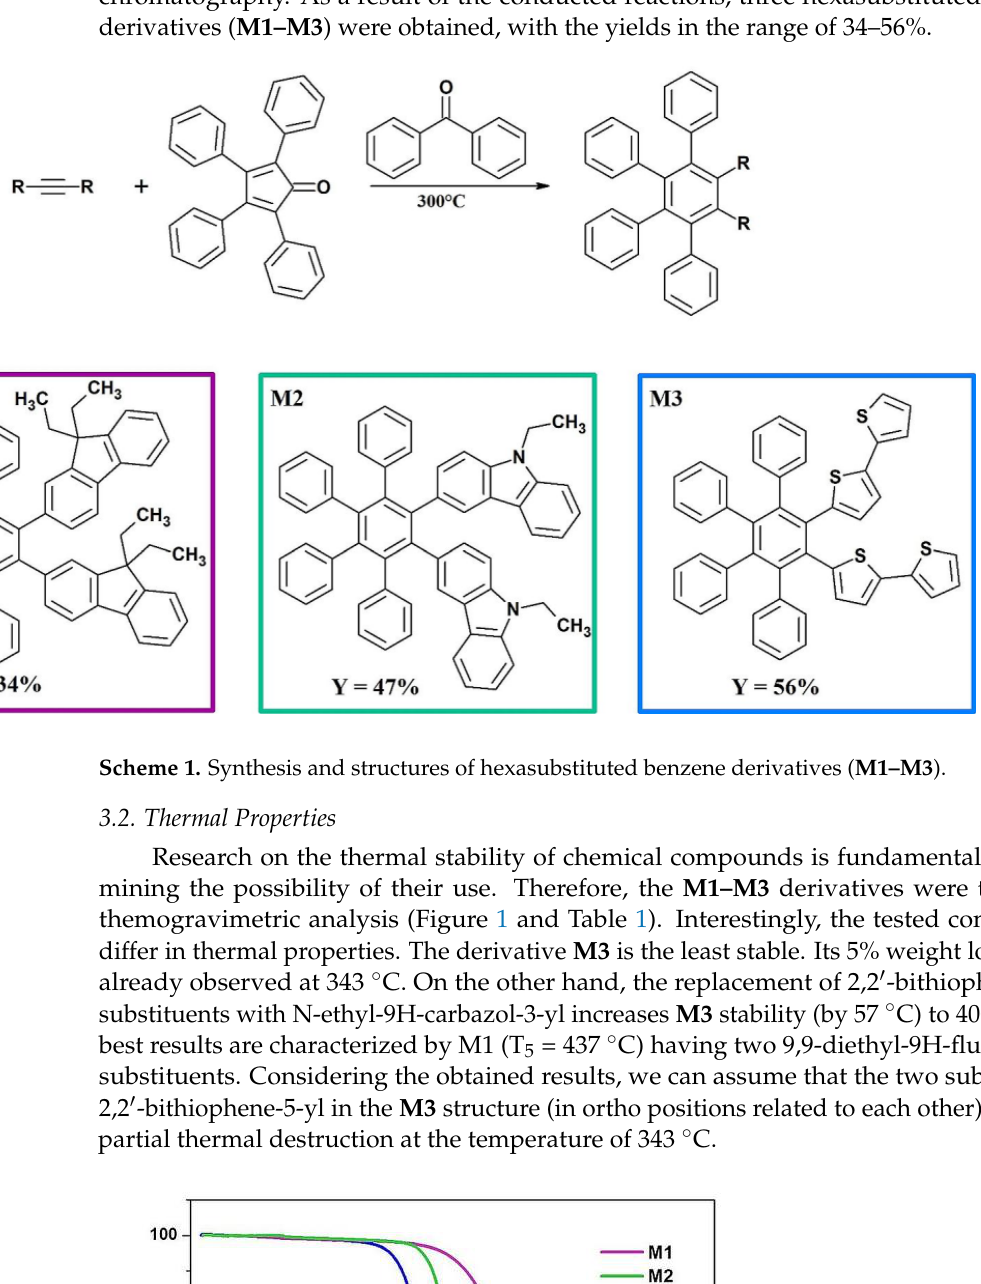
Table 1. Thermal stability of M1–M3 .